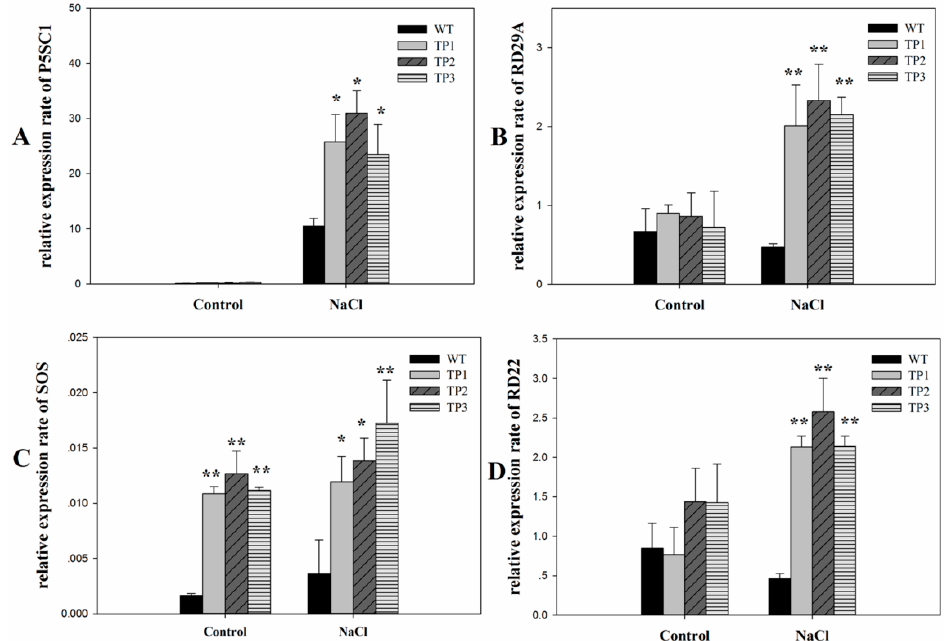
Figure 7. Relative expression rates of salt stress-related genes in 3-week-old seedlings of wild-type and transgenic plants under normal and salt stress conditions. ( A ) P5SC1; ( B ) RD29A; ( C ) SOS1; ( D ) RD22. All experiments were repeated at least three times. Error bars indicate the standard deviation (SD). * and ** indicate that the values of the transgenic plants were significantly different from those of the wild type under the same conditions with P < 0.05 and P < 0.01.